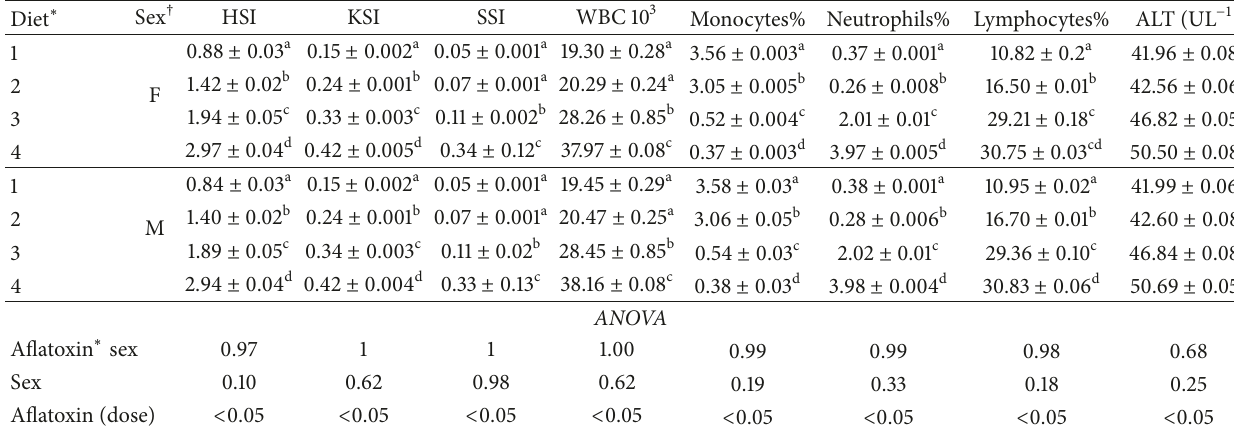
Table 2: Mean ± SE of relative organ weights (g organ per 100g body weight), white blood cells, differential counts, and liver enzymes (e.g., alanine aminotransferase (ALT)) of male and female O. niloticus exposed to different levels of AFB 1 for 24